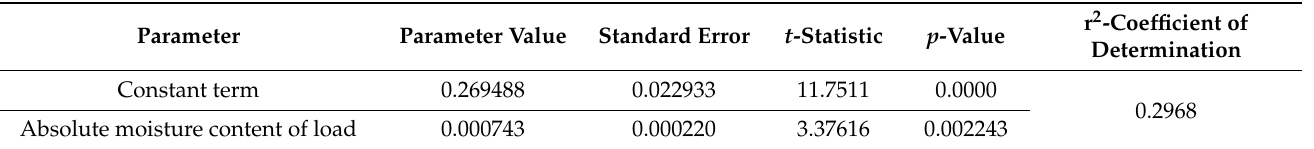
Table 10. Evaluation of model parameters on the dependence of sawdust bulk density (Mg · m − 3 ) on absolute moisture content. Parameter Parameter Value Standard Error Constant